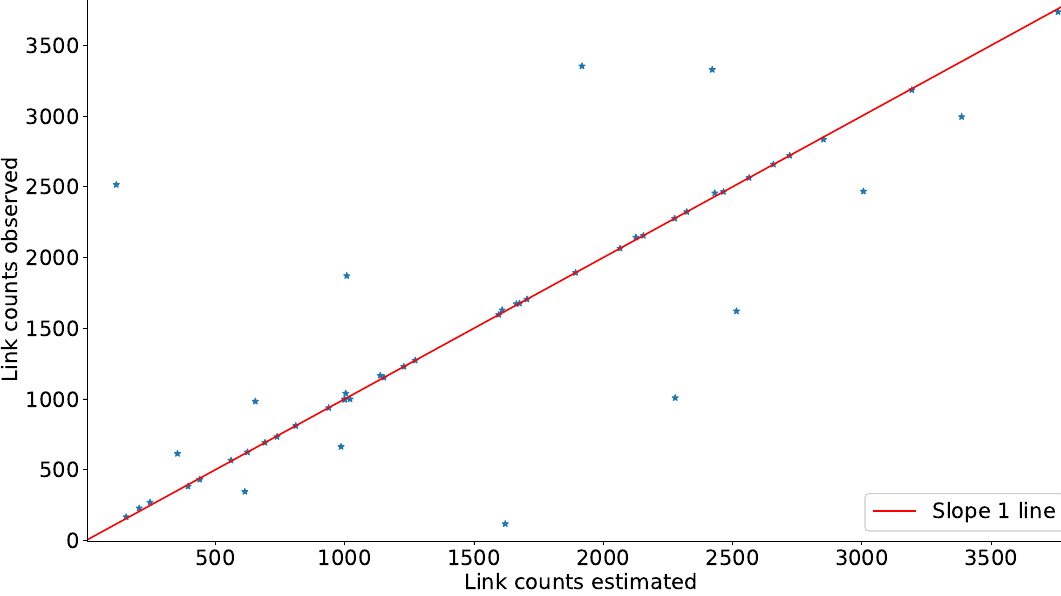
Figure 12. Scatter plot to compare estimated link count with the observed link